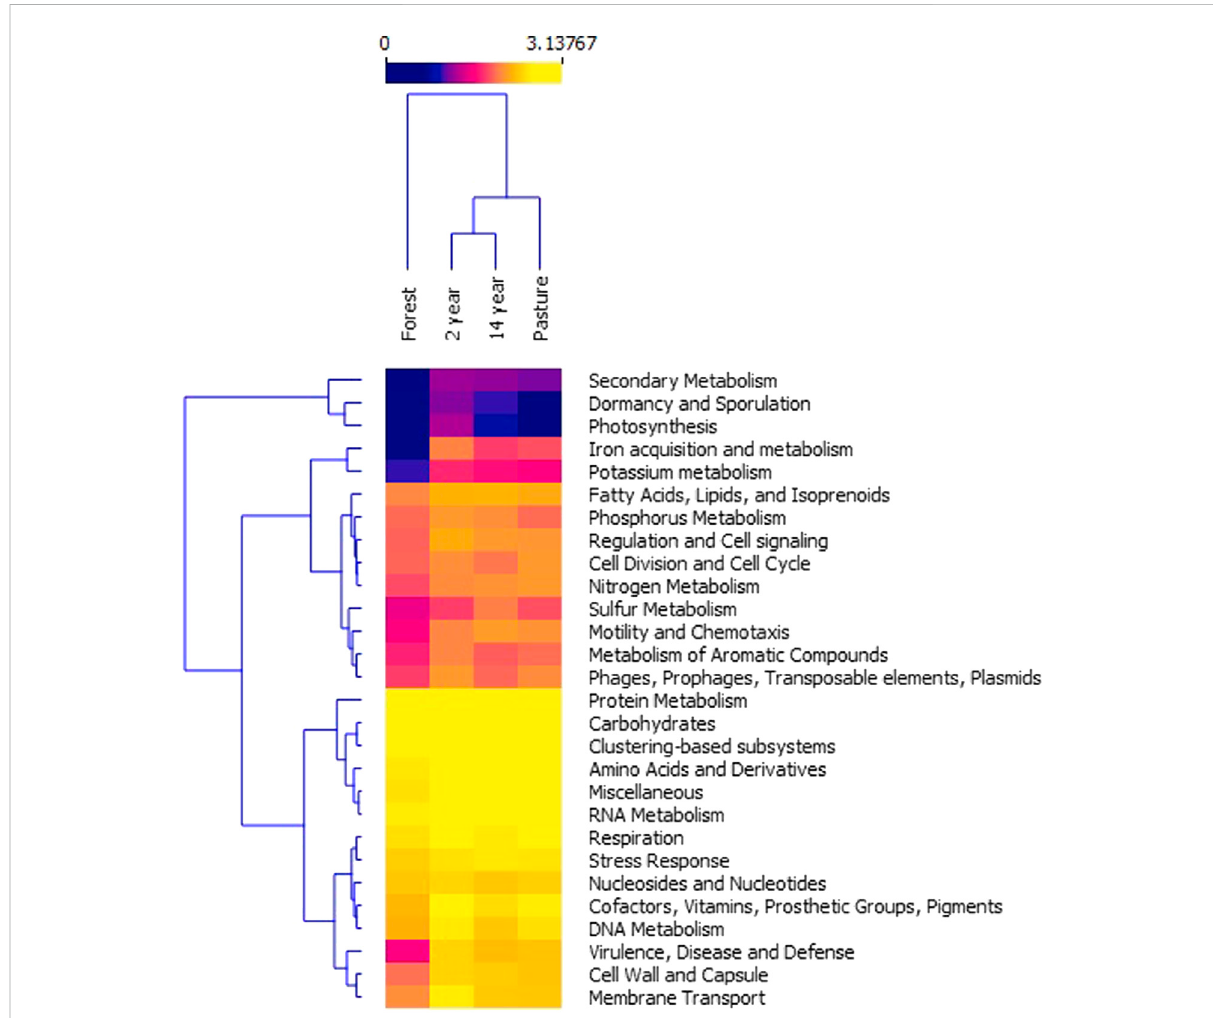
FIGURE 5 Heatmap of the logarithm of the relative abundance of the functional annotations identi fi ed in the sites, using level 1 of the SEED Subsystems database. Permission to reuse and